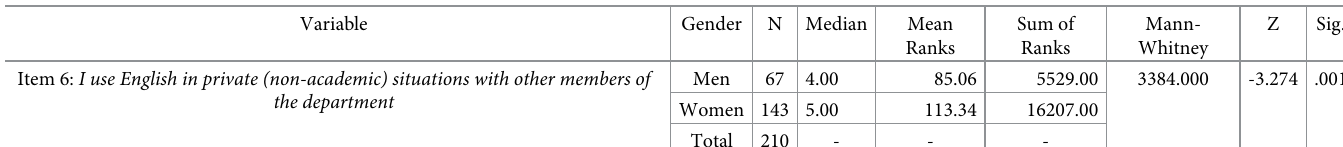
Table 12. Mann-Whitney